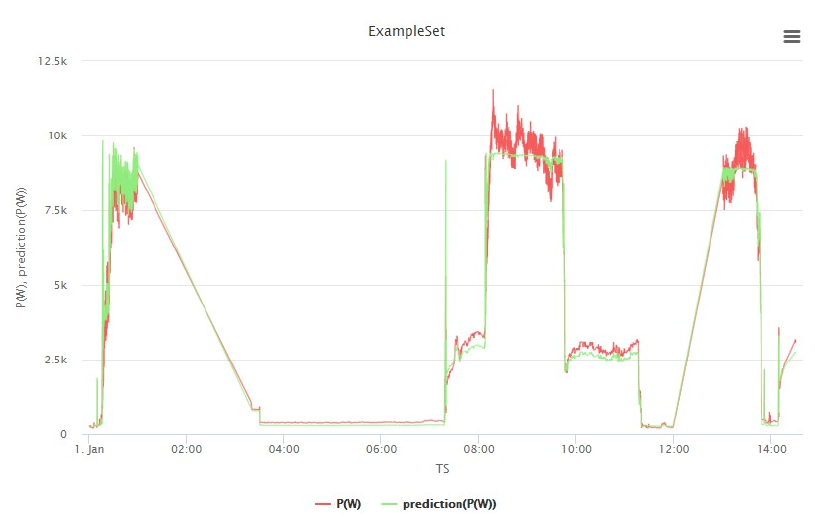
Figure 18. Visualization graph of ANN model.